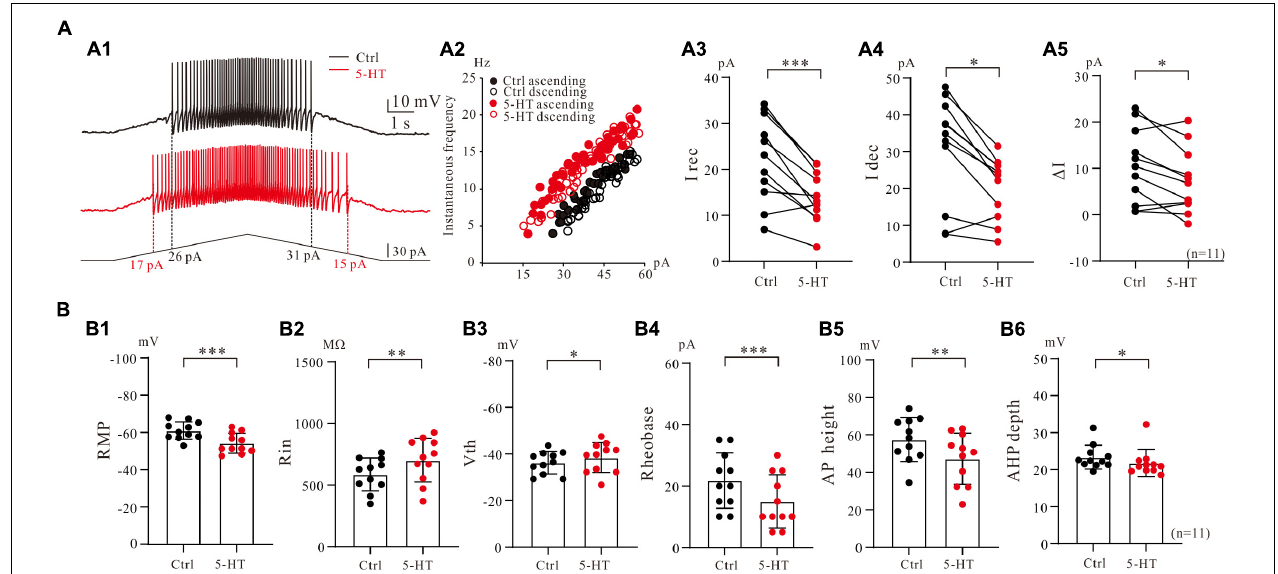
FIGURE 6 | 5-HT modulation of firing properties of 5-HT neurons. (A1) Repetitive firing evoked by bi-ramp current injected (10 s duration) into a 5-HT neuron (black). A 10 µ M 5-HT was then applied to the recording solution (red). (A2) Instantaneous firing frequency/current relationship for both control and 5-HT conditions. (A3–A5) Values measured for recruitment current, decruitment current and (cid:49) I in control (black) and bath application of 15 µ M 5-HT (red). (B1–B6) Summary diagrams show 5-HT-induced significant changes in the membrane properties including resting membrane potential (RMP), input resistance (Rin), voltage threshold (Vth), rheobase, action potential height (AP height) and afterhyperpolarization depth (AHP depth) recorded in control and presence of 15 µ M 5-HT ( n = 11). Error bars show SD. ∗ P < 0.05, ∗∗ P < 0.01, ∗∗∗ P < 0.001, paired t -test.